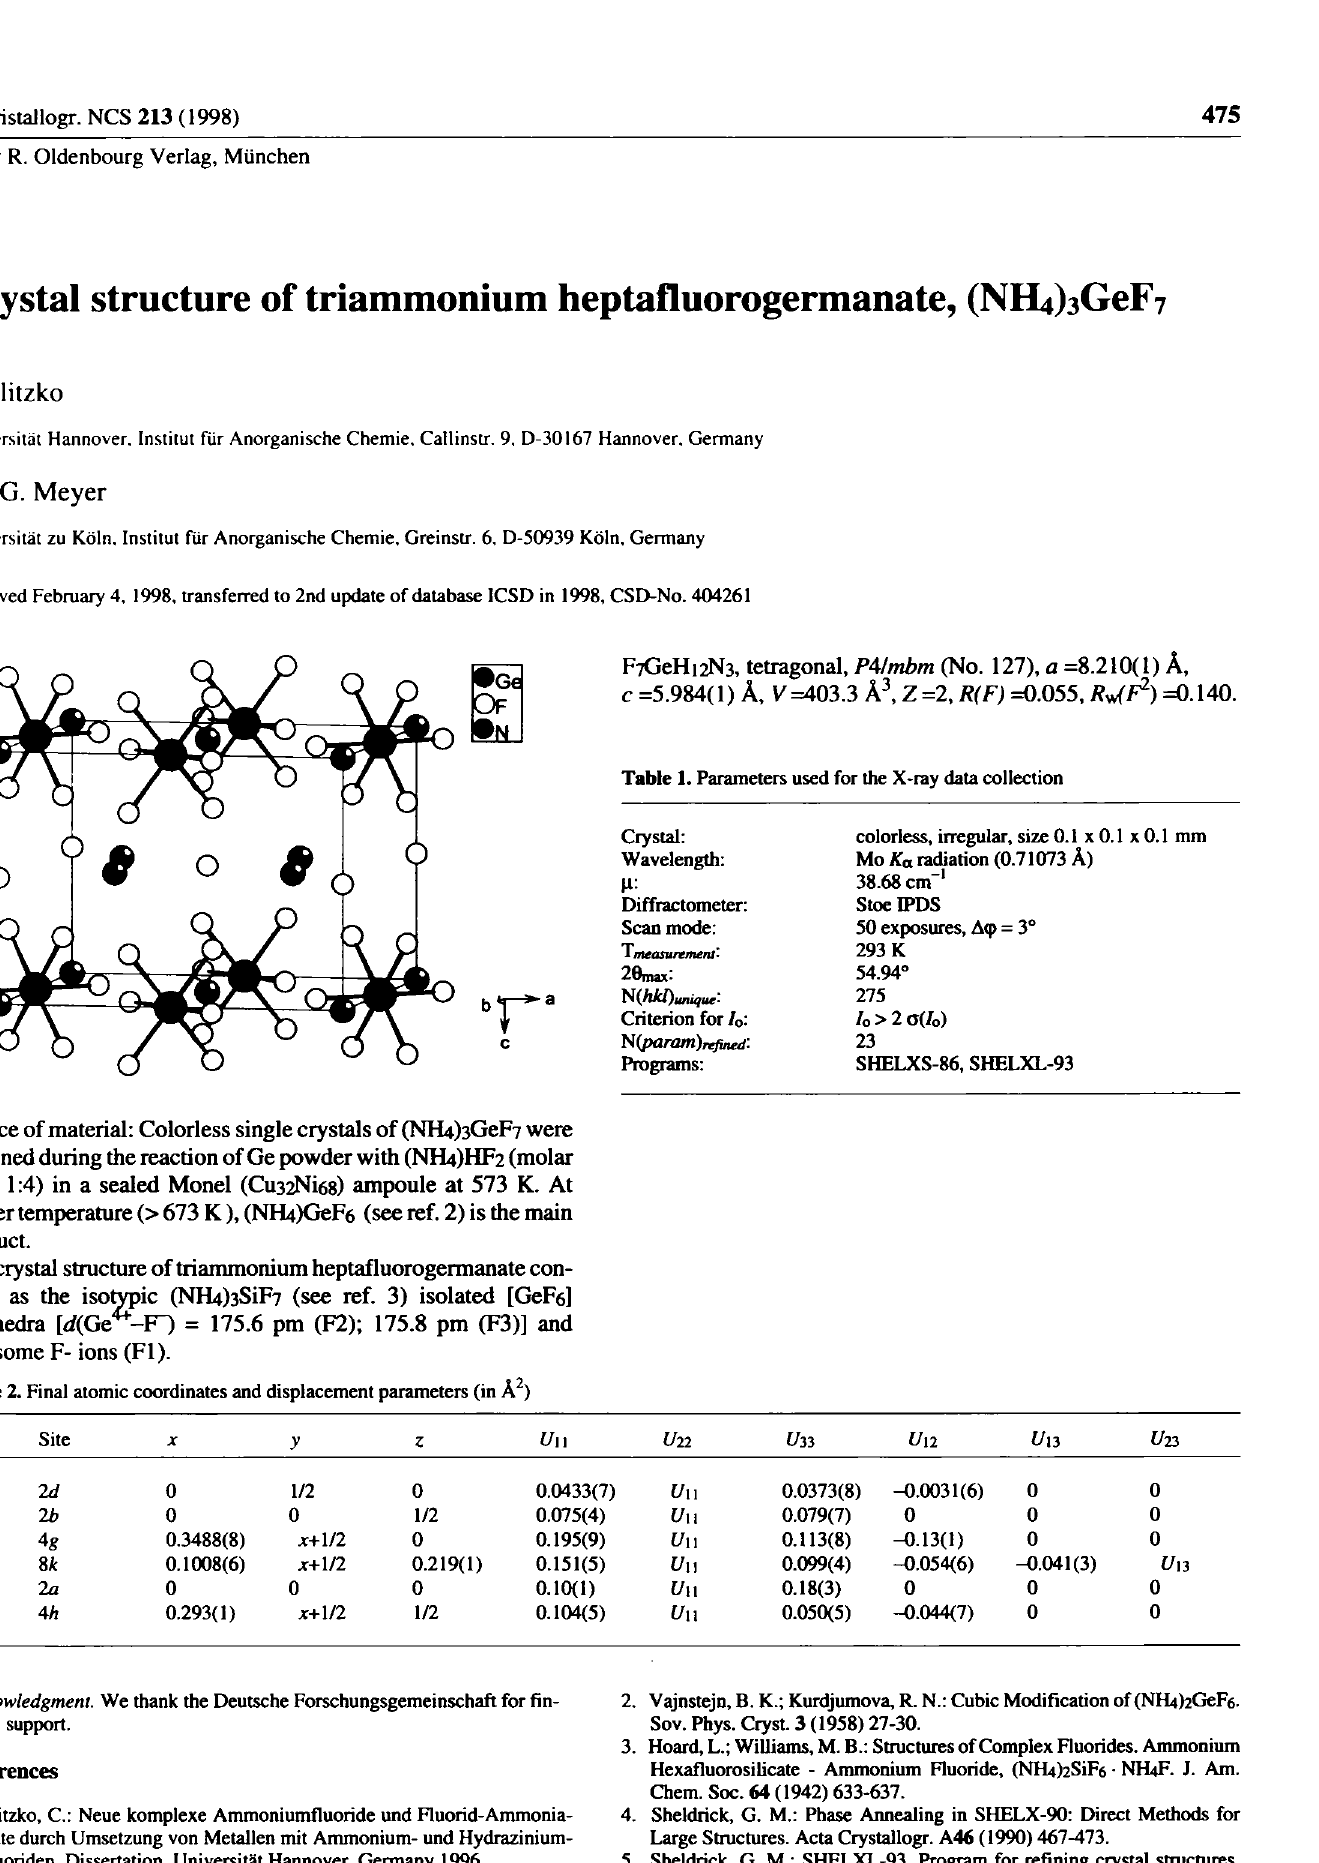
Table 2. Final atomic coordinates and displacement parameters (in Â^)